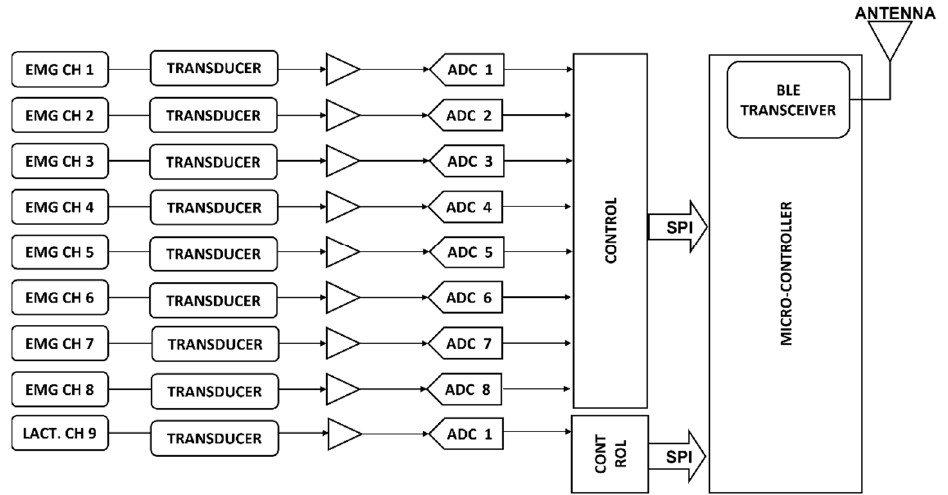
Figure 2. Multi-channel acquisition system to interface at the multi-sensing system in Figure 1. EMG = electromyographic sensor; LACT = lactate biosensor.